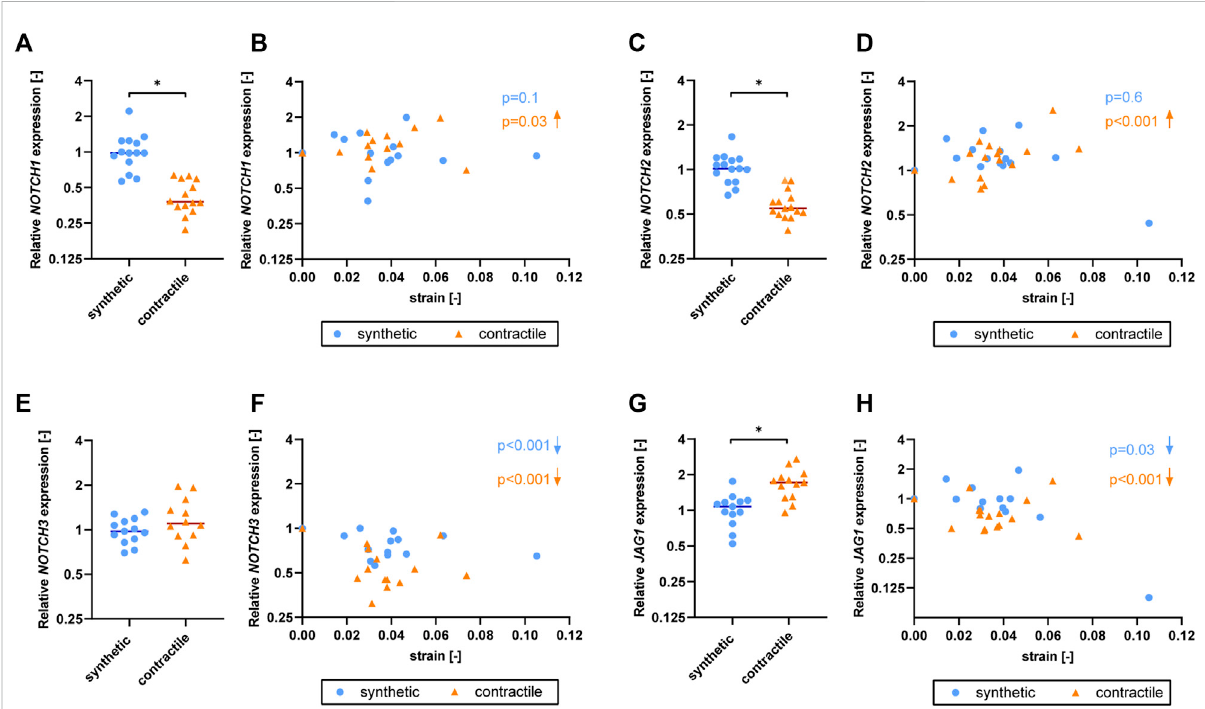
FIGURE 6 The effect of strain on Notch pathway genes for synthetic and contractile VSMCs. Gene expression of Notch signaling components (A,B) NOTCH1 , (C,D) NOTCH2 , (E,F) NOTCH3 and (G,H) JAG1 forsynthetic(bluecircles)andcontractile(orangetriangles)VSMCs (A,C,E,G) intheabsence of strain (normalized to the synthetic control) and (B,D,F,H) as a function of strain (each data point is normalized to its corresponding static control expression). p values show the signi fi cance level of non-parametric Spearman correlation coef fi cient. The arrows next to signi fi cant correlations ( p < 0.05 ) demonstrate an up or downregulation in gene expression with applied strain